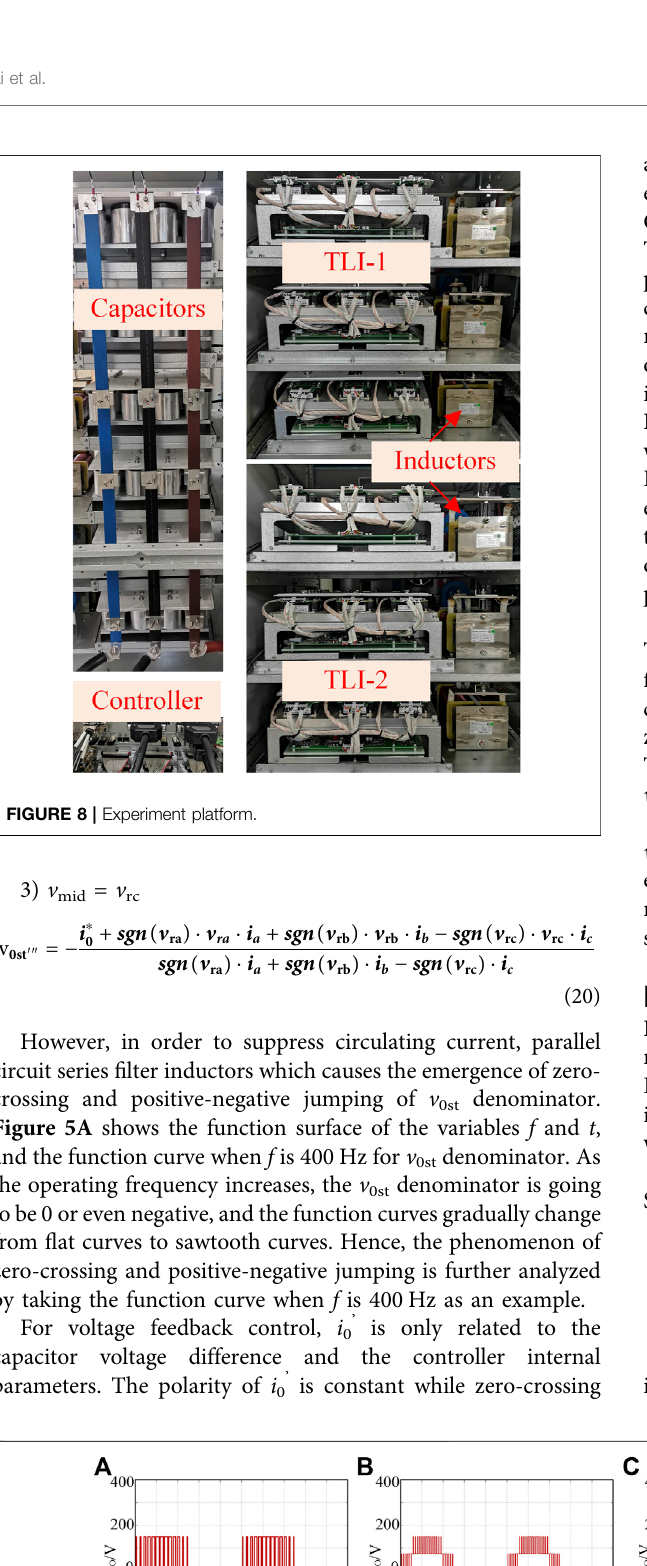
Frontiers in Energy Research |